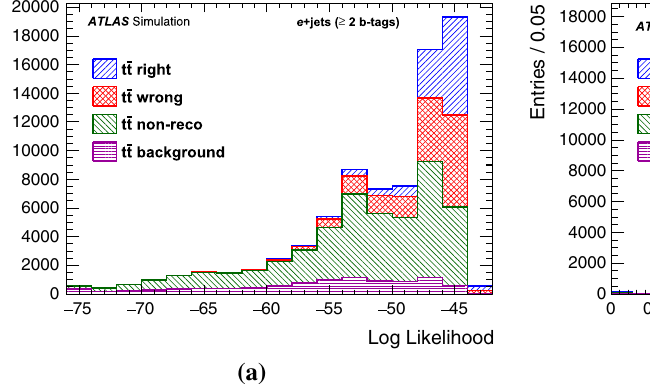
Fig. 1 a Logarithm of the likelihood value as output for reconstructed t ¯ t events of the selected (best) jet-to-parton permutation. b Event prob- ability for the selected (best) jet-to-parton permutation. Both distribu- tions show events in the e + jets channel with ≥ 2 b -tags. Events from a